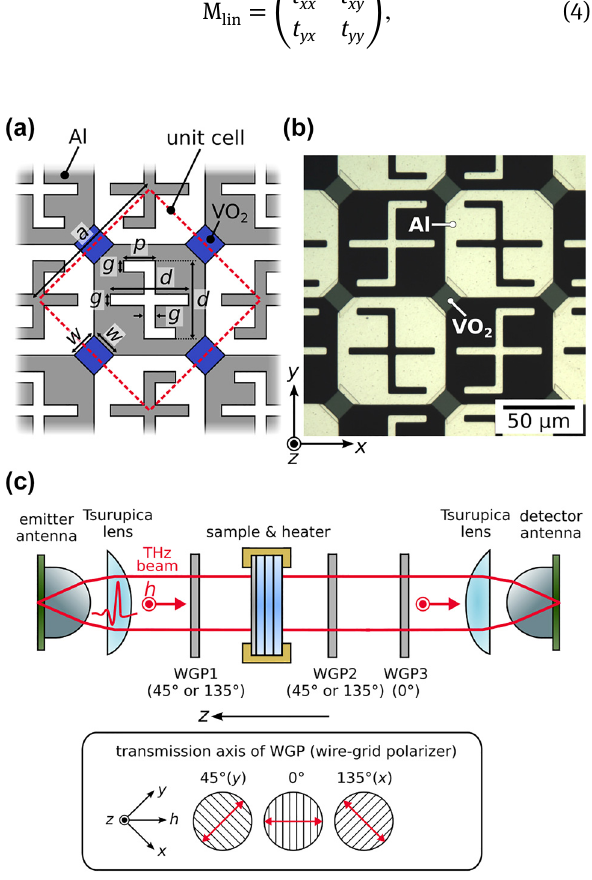
Figure 2: (a) Schematic of the designed metasurface. The red dashed square indicates the unit cell of the metasurface